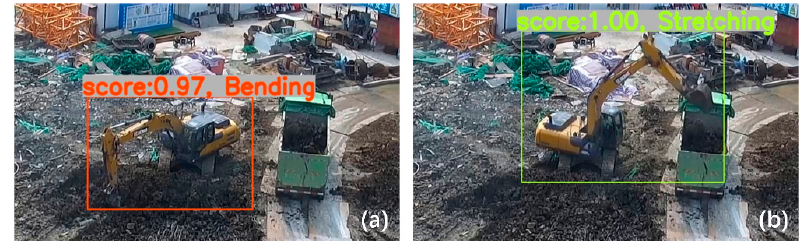
Figure 5. Recognition results for atomic actions: ( a ) bending and ( b )